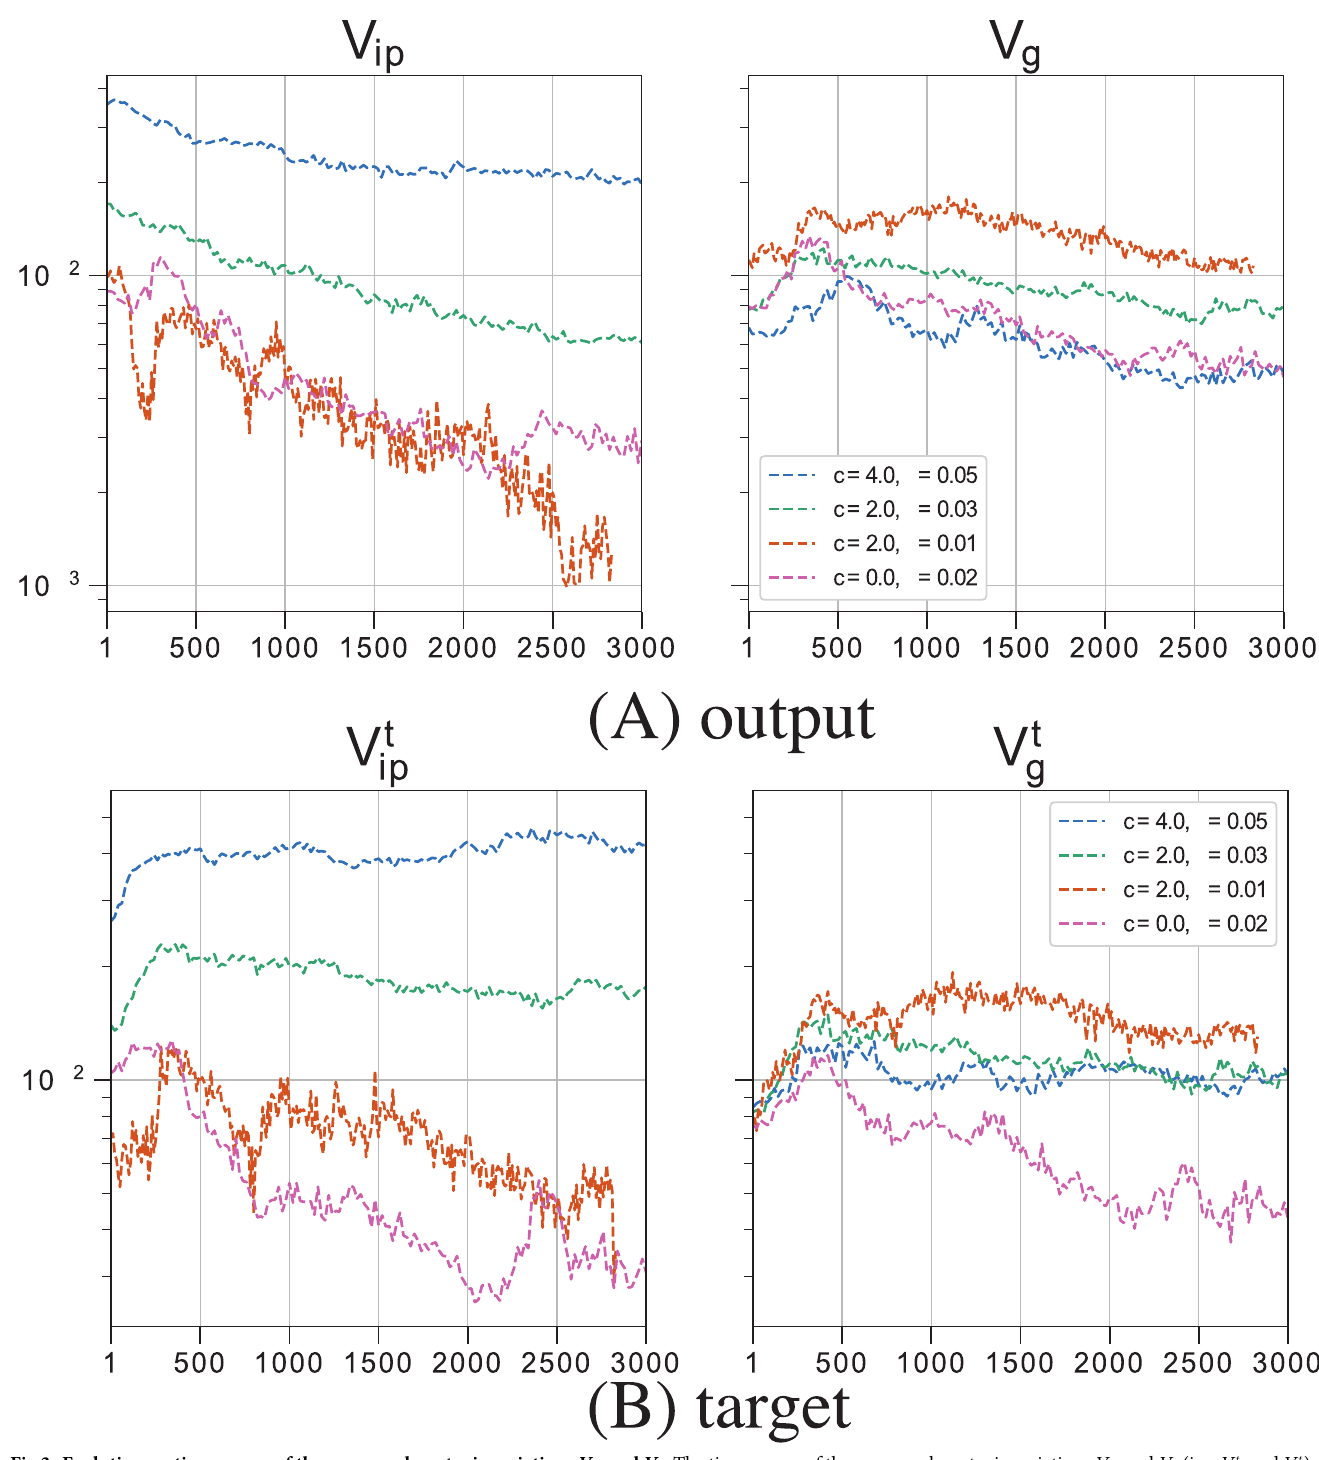
Fig 3. Evolutionary time course of the average phenotypic variations V ip and V g . The time course of the average phenotypic variations V ip and V g (i.e., V t The plot is from the first generation rather than 0th generation. Note that host types that went extinct during the simulation have been excluded. This explains the different initial variance levels between parameter combinations. (A) Average V ip and V g over all output genes are plotted against the generation for different values of the noise level σ and interaction strength c , as indicated by different colors. Red: Example of evolution with no host–parasite interactions. Hosts are occupied by individuals with the fittest phenotype, thereby losing phenotypic diversity ( σ = 0.02). Both the isogenic phenotype variation V ip and the genetic variance V g decrease. Orange: Case with c = 2 and σ = 0.01, which shows that V ip decreases, whereas V g maintains high values, implying the evolution of genotypic diversity. Green: c = 2 and σ = 0.03. Both V ip and V g increase. Blue: c = 4 and σ = 0.05. V ip decreases slightly, whereas V g maintains low values. (B) V t represent the equivalent conditions as in